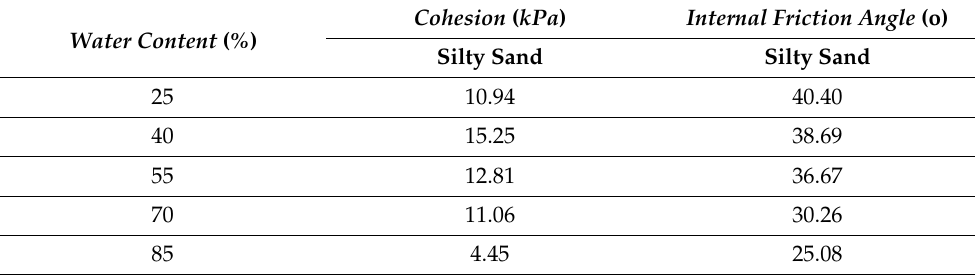
Table 2. Shear strength parameters under different water